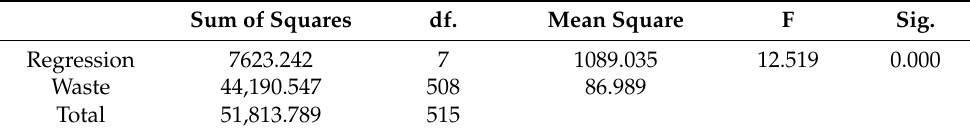
Table 7. ANOVA result for Model